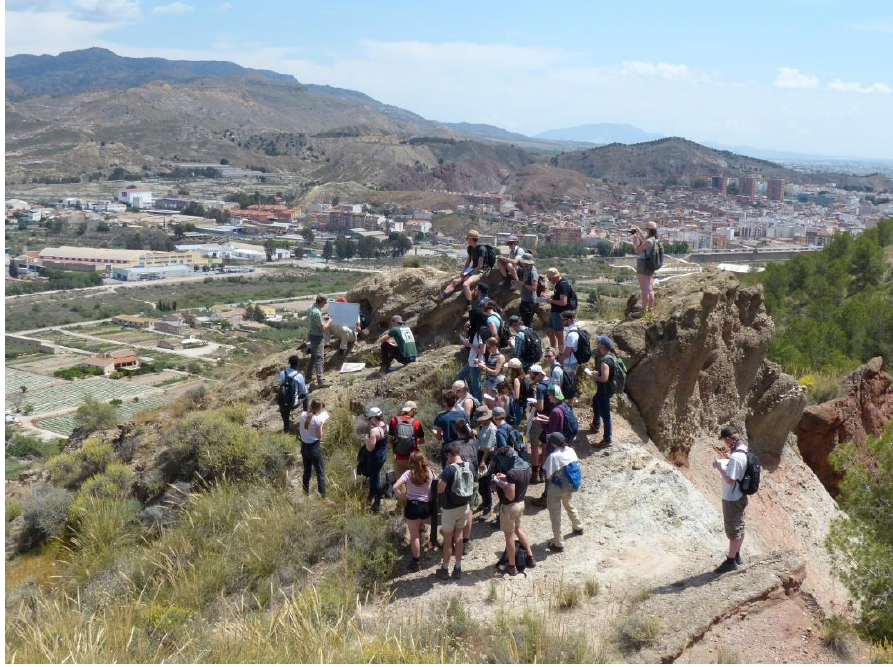
Figure 2. Scientific information being given to the GB-V group at Lorca (geosite 13; © J. Poesen, May 2019).